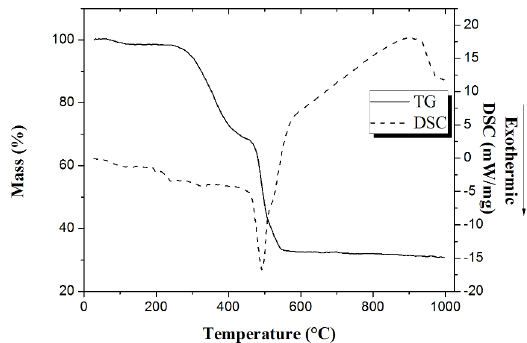
Figure 1. Thermogravimetric analysis curve for cerium molybdate